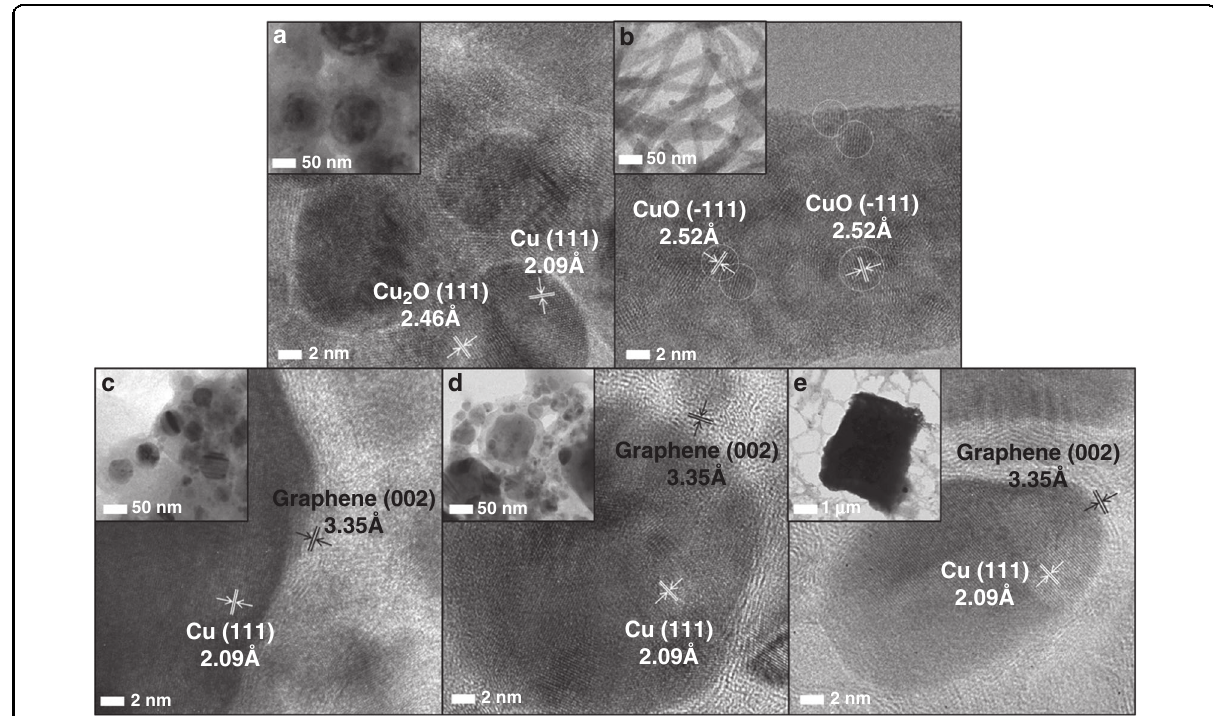
Fig. 8 HR-TEM surface morphology with lattice distances of materials obtained by the PLA of the Cu-plate in various solvents. a DI water, b methanol, c ethanol, d hexane, and e ACN. The insets show the TEM images of the resulting products 10 . Copyright (2021)